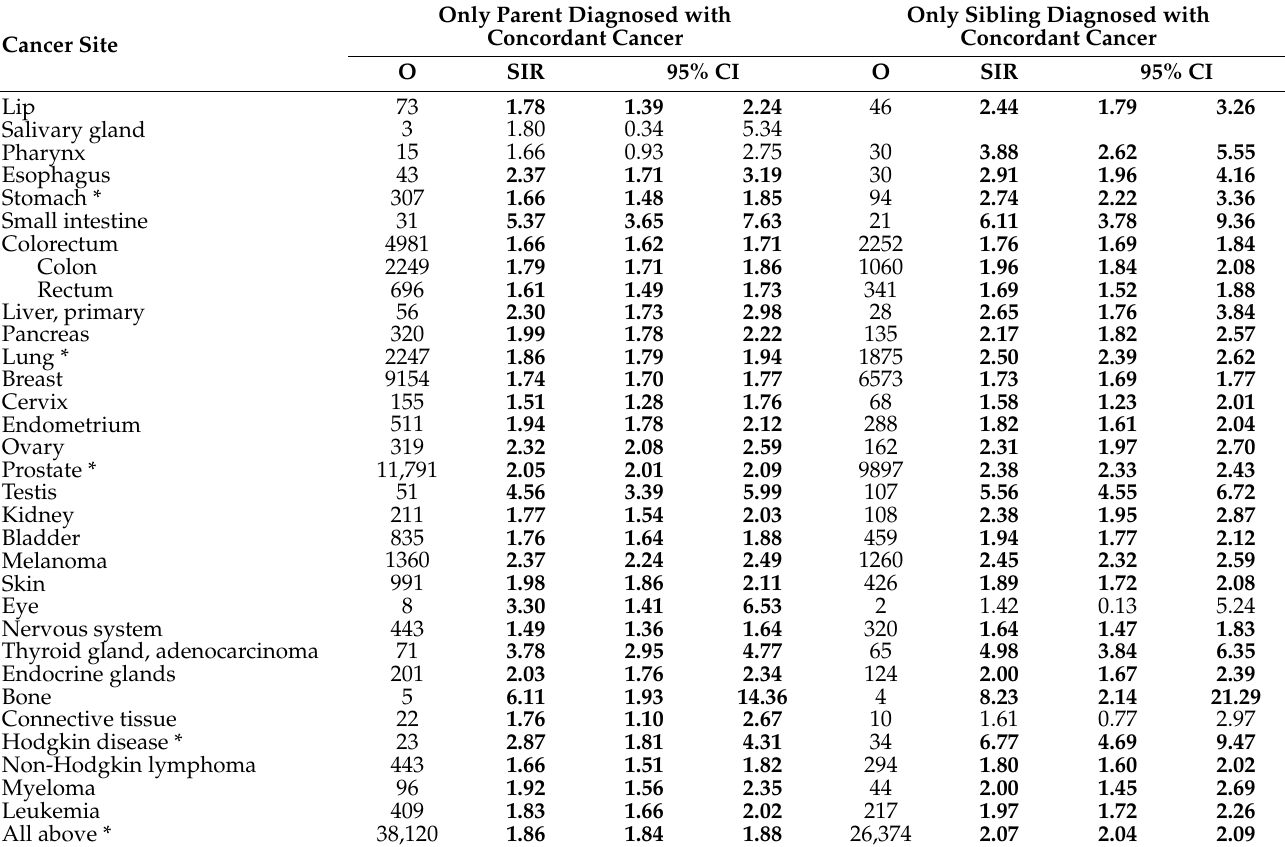
Only Sibling Diagnosed with Concordant Cancer